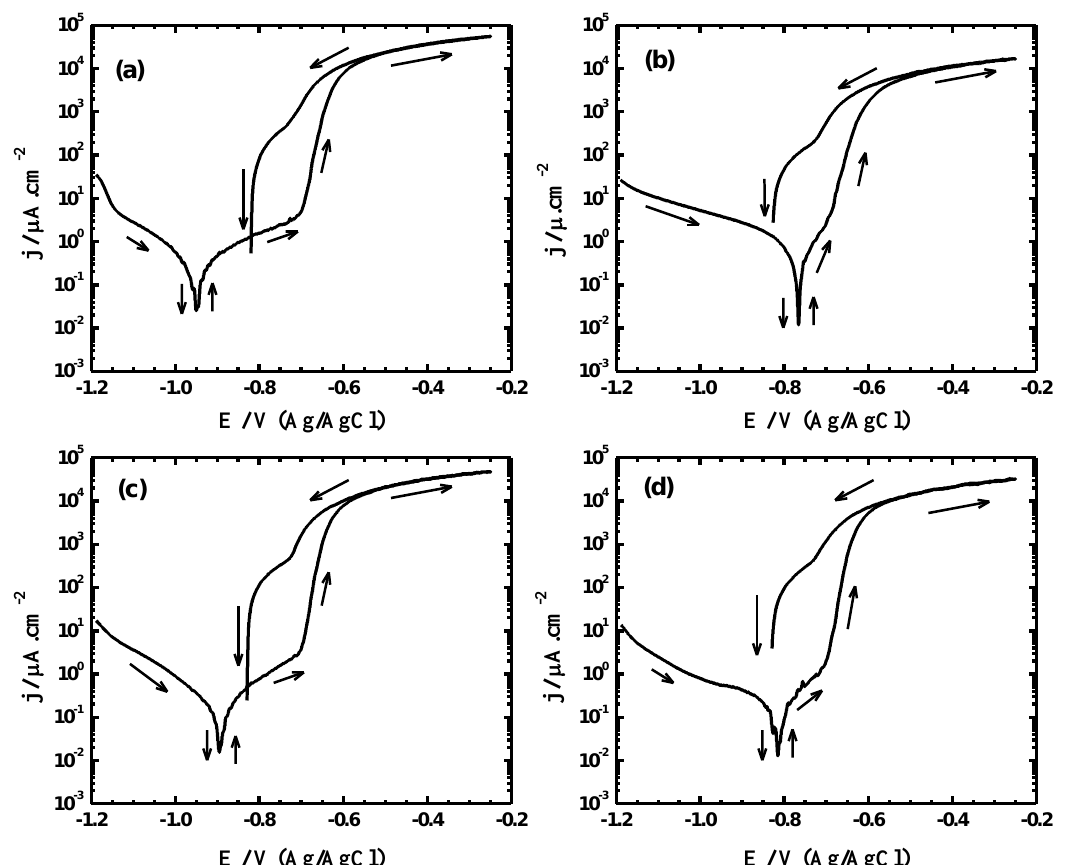
Figure 1. Polarization of AA 6061 alloys, ( a ) the as received and the extruded alloys ( b ) 350, ( c ) 425, and ( d ) 500 °C, after immersion in 3.5% NaCl solutions for 1 h.